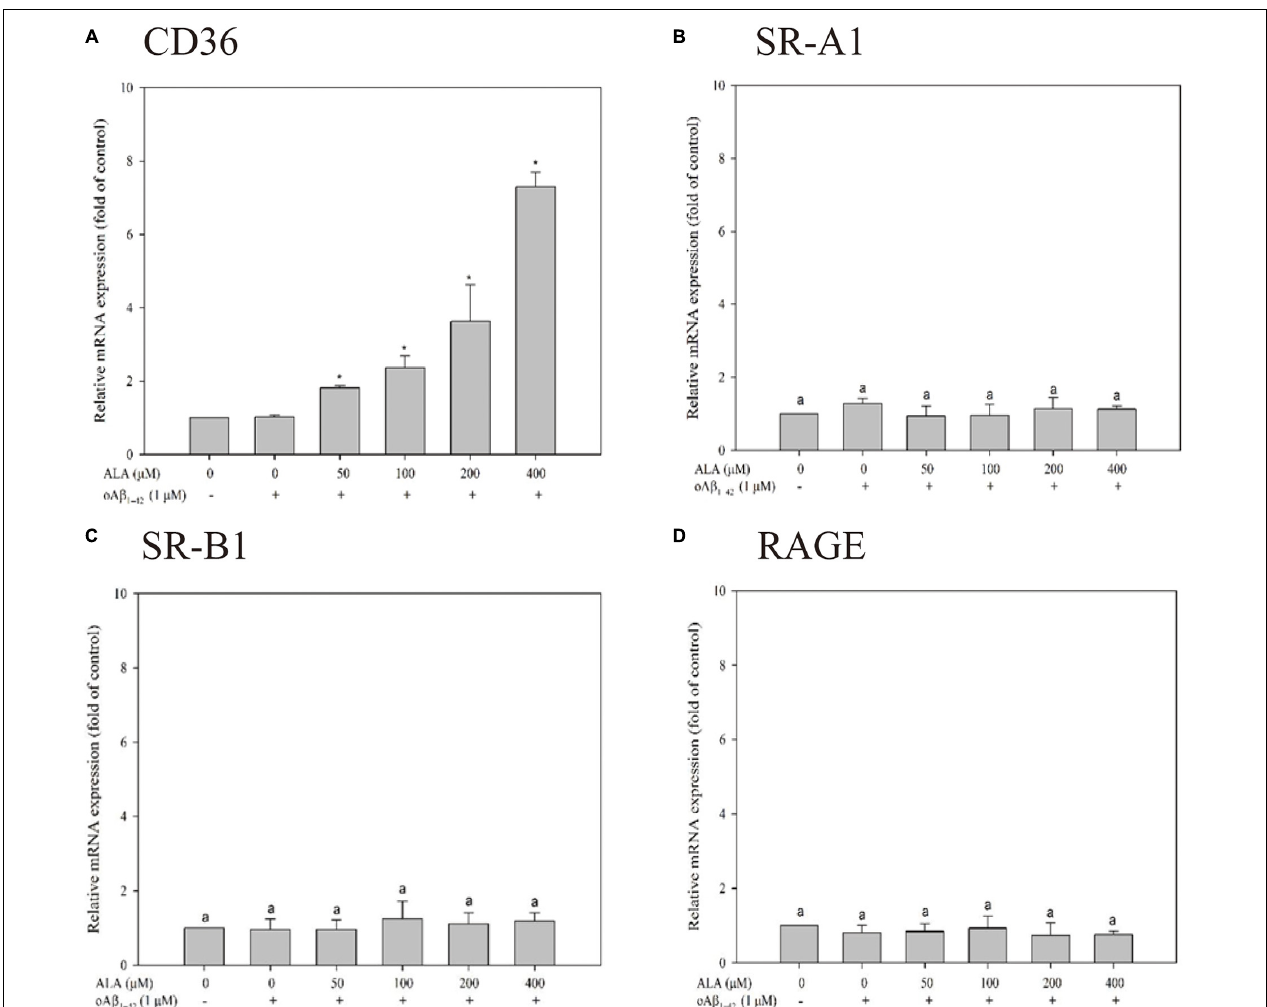
FIGURE 3 | Messenger RNA (mRNA) expression of oA β 1 − 42 phagocytosis-related receptor including CD36 (A) , scavenger receptor A1 (SR-A1) (B) , scavenger receptor B1 (SR-B1) (C) , and receptor for advanced glycation endproducts (RAGE) (D) in BV-2 mouse microglial cells. BV-2 cells were pretreated with or without different concentrations of ALA for 30 min, followed by oA β 1 − 42 treatment for 24 h. The relative mRNA expression of CD36, SR-A1, SR-B1, and RAGE was detected using real-time PCR. * p < 0.05 vs. the control group.